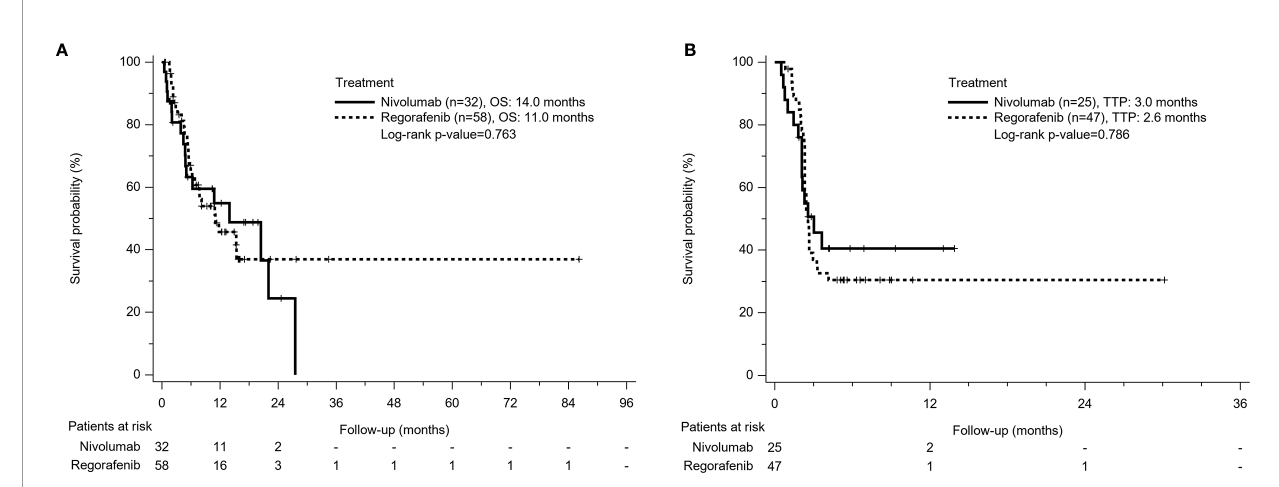
FIGURE 2 | Kaplan-Meier survival curves of treatment outcome including (A) overall survival (OS) and (B) time to progression (TTP) between Nivolumab group and Regorafenib group. The comparison of OS and TTP in both groups was not different.